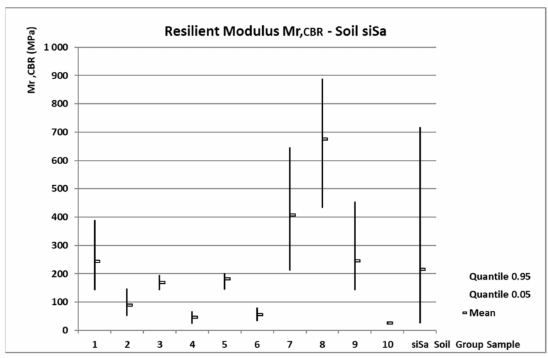
Figure 7. Statistical quantities—mean, 0.05 quantile, 0.95 quantile of M r,CBR for siSa